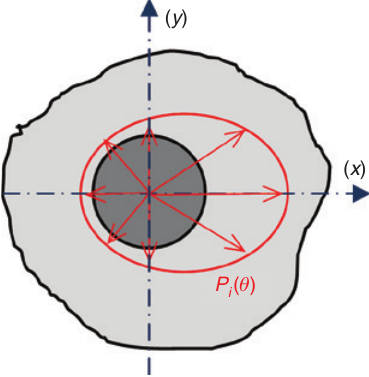
Figure 1: An arbitrary load distribution induced by the inner part of the